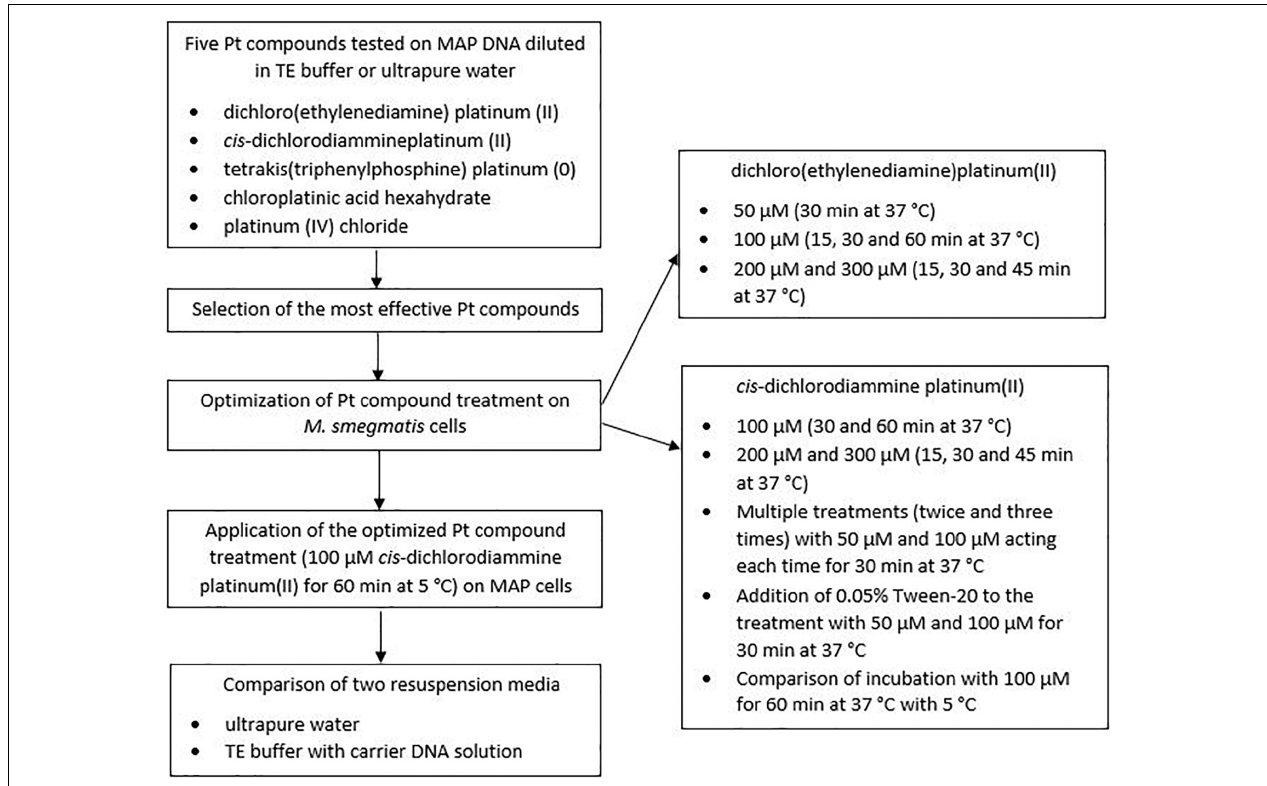
FIGURE 1 | Schematic overview of the optimization of Pt compound